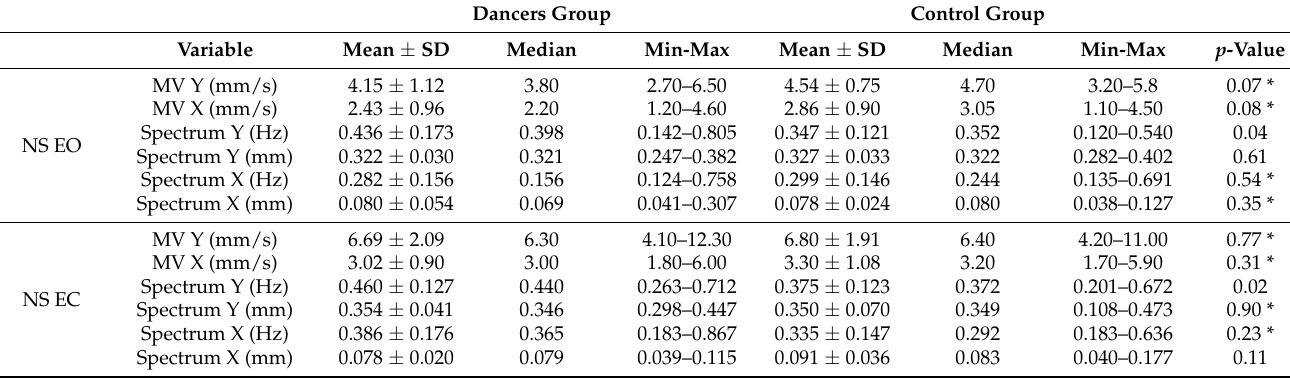
Table 2. Comparison of results obtained with normal standing, eyes open (NS EO) and eyes closed (NS EC) positions in the dancers and control groups.